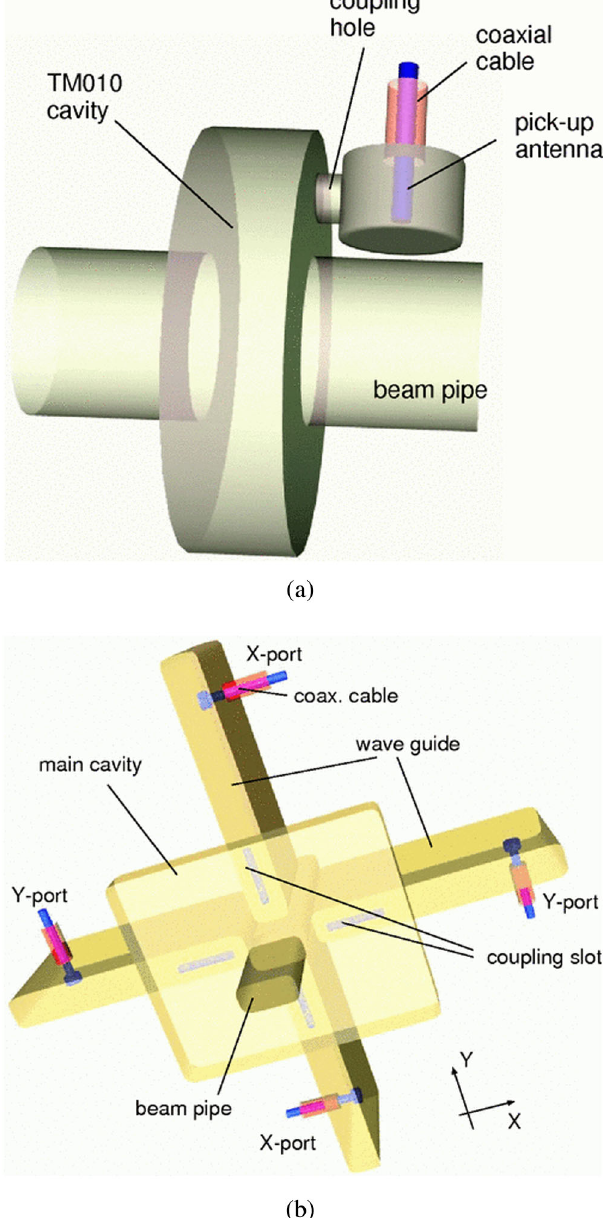
FIG. 4. Schematic of the (a) cylindrical reference cavity BPMs and (b) rectangular dipole cavity BPMs